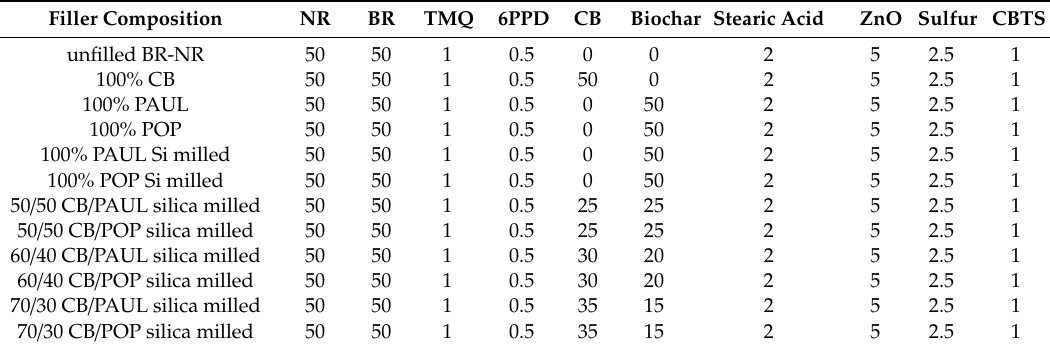
Table 1. 33% Total Filler Control and Composite Formulations (phr).